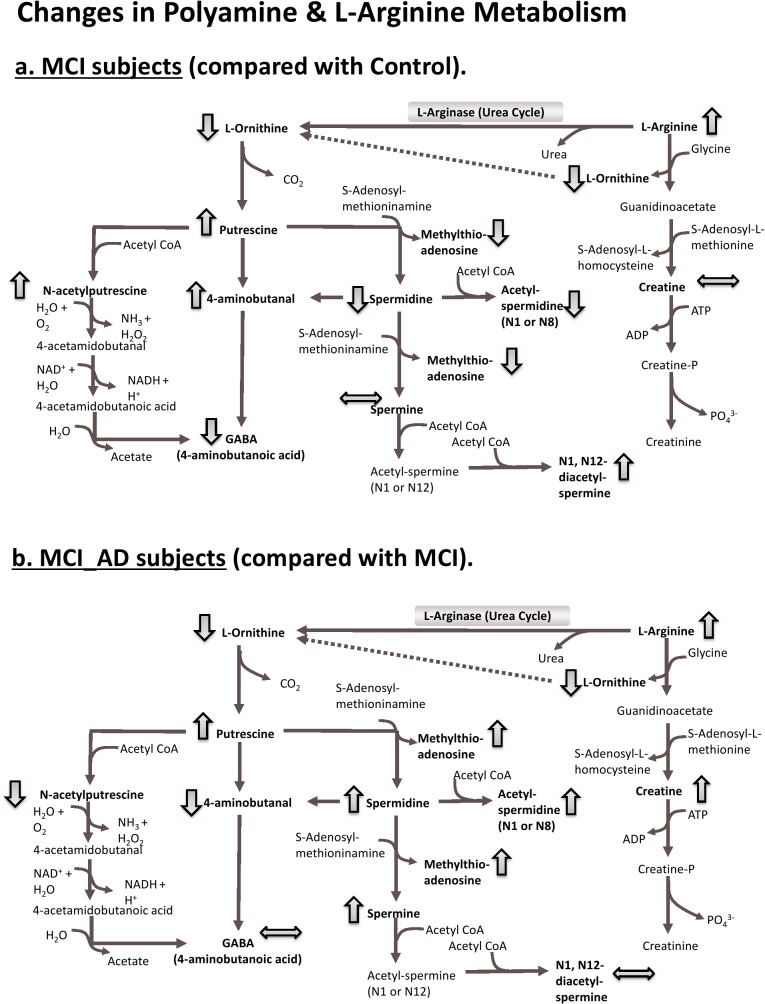
Changes in Polyamine and L-Arginine Metabolism.Pathway enrichment data indicates that Polyamine metabolism and L-arginine metabolism are differentially affected in stable MCI subjects (a.) and MCI subjects converting to AD subjects (b.). Conversion to AD (b.) preferentially channels putrescine towards the production of spermidines and spermines, whereas in stable MCI (a.) the fate of putrescine is the formation of N-acetylputrescine and 4-aminobutanal. Decline in the production of the neurotransmitter GABA occurs in stable MCI (a.) and is not further affected by conversion to AD. GABA decline is associated with a build-up of its precursor metabolites, N-acetylputrescine and 4-aminobutanal. Arrows indicate increases (↑), decreases (↓) or unchanged (↔) levels of metabolites.